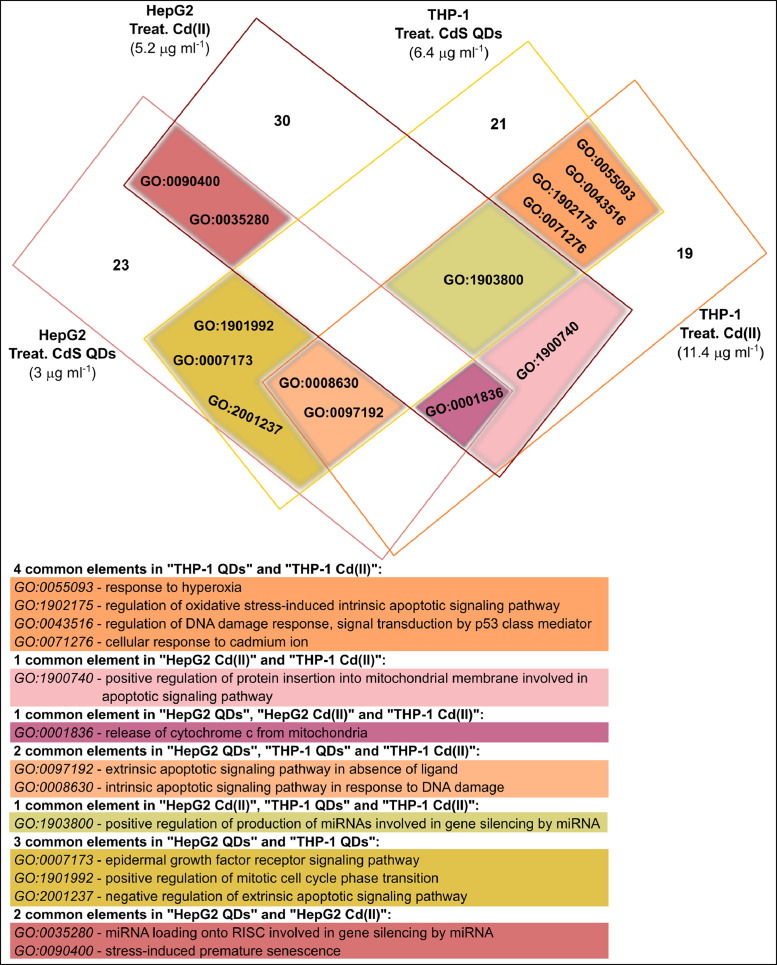
Commonalities of target genes in the two cell types targeted by Cd stress-responsive miRNAs. The stress was induced by exposure to 2.3 µg ml−1 Cd (for HepG2), in the form of either 3 µg ml−1 CdS QDs or 5.2 µg ml−1 Cd(II), and 5 µg ml−1 Cd (for THP-1), as 6.4 µg ml−1 CdS QDs or 11.4 µg ml−1 Cd(II). Some categories were common to exposure to CdS QDs and Cd(II): ‘extrinsic apoptosis in the absence of ligands’ and ‘intrinsic apoptosis in response to DNA damage’. A similar comparison between HepG2 and THP-1 cells challenged with Cd(II) revealed as common GO categories 'positive regulation of protein insertion into mitochondrial membrane involved in apoptotic signaling pathway' and 'release of cytochrome c from mitochondria'.